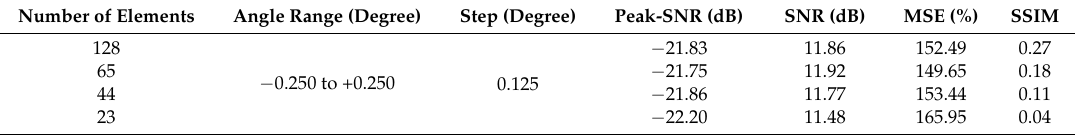
Table 9. Image quality values with the Verasonics image of the reference to cyst